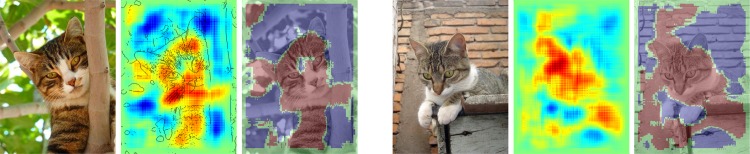
Pixel-wise decomposition for Bag of Words features over a histogram intersection kernel using the layer-wise relevance propagation for all subsequent layers and rank-mapping for mapping local features.Each triplet of images shows—from left to right—the original image, the pixel-wise predictions superimposed with prominent edges from the input image and the original image superimposed with binarized pixel-wise predictions. The decompositions were computed on the whole image. Positive responses seem to exist for certain fur texture patterns, see also the false responses on the wood and the plaster in the second example which both have similar texture and color to a cat’s fur. Images by Pixabay users LoggaWiggler and Holcan.